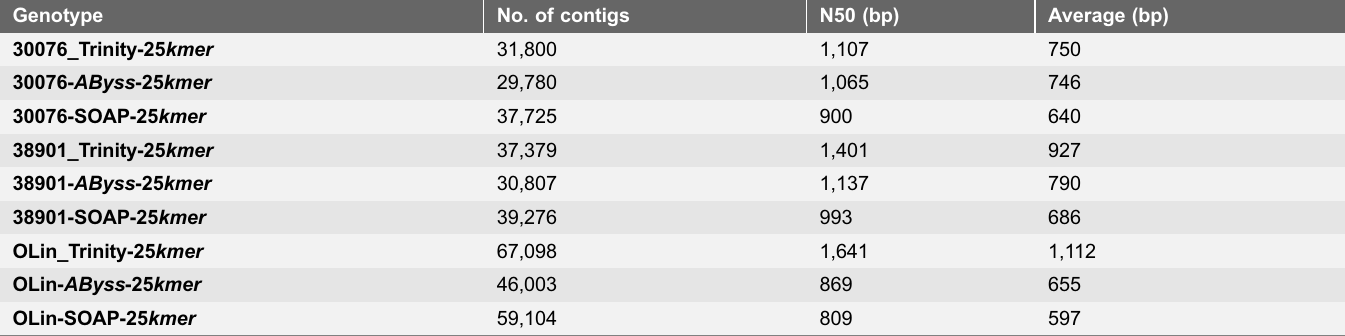
Table 2. Statistics on de novo assemblies generated at kmer 5 25 using Trinity, AByss and SOAPdenovo-Trans.